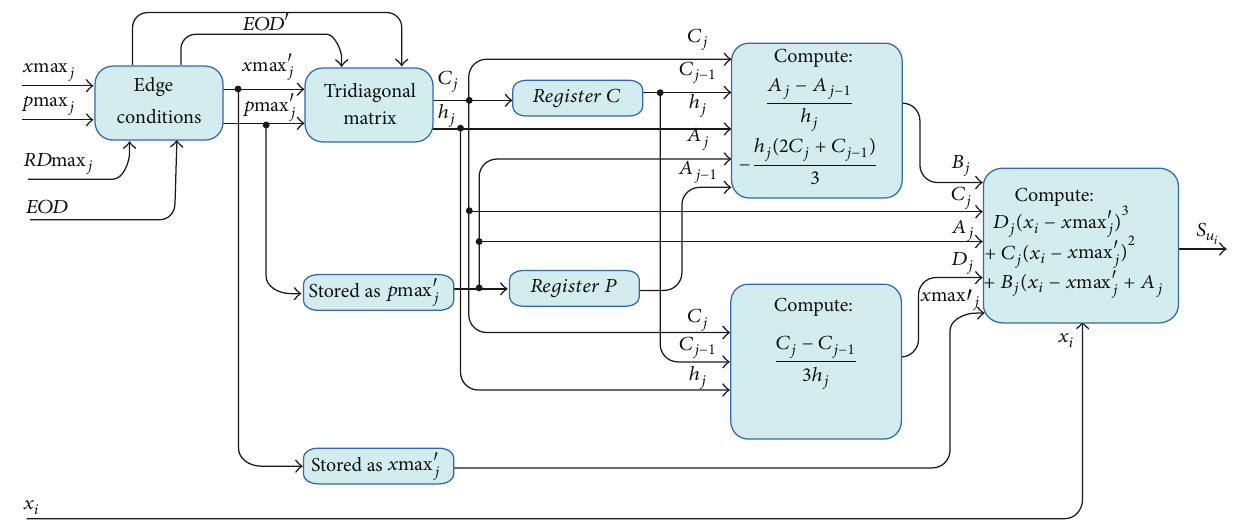
Figure 10: Block diagram of the spline-cubic interpolation module.